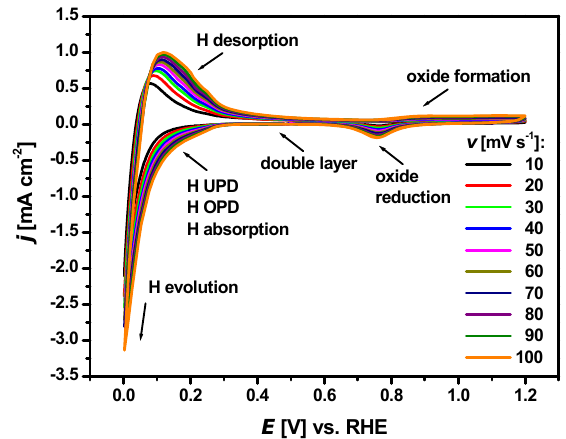
Figure 2. Cyclic voltammograms in the hydrogen and oxygen regions at v = 10–100 mV s − 1 at 50 µ m Pd 80 Rh 20 electrode in 0.1 M H 2 SO 4 at 25 ◦ C.